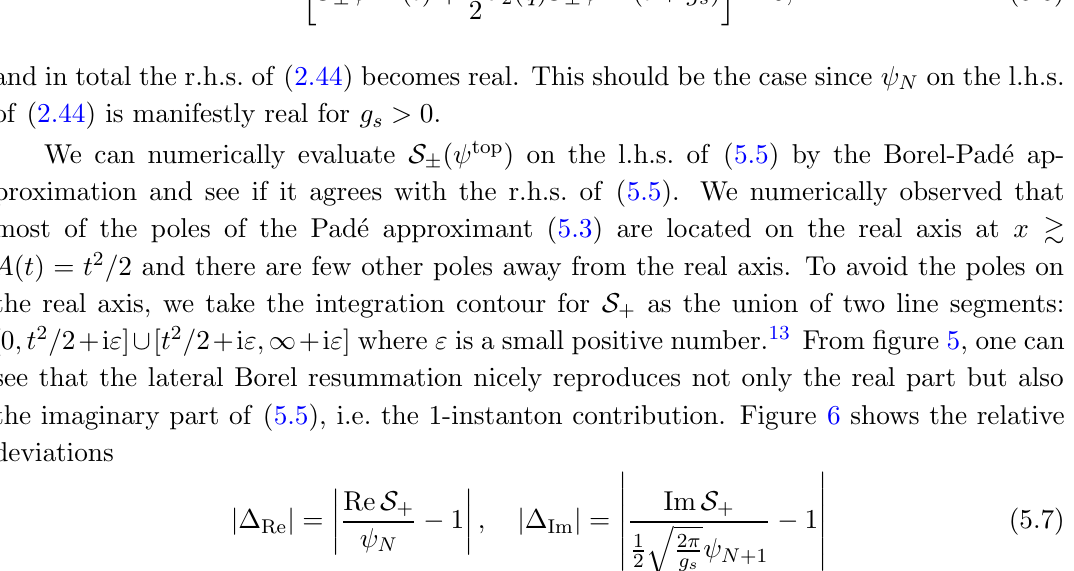
Figure 5 . Comparison of the nonperturbative result N + i Borel resummation S + ( top ) (blue solid line) at g s = 1. The real part (left) and the imaginary part (right) are plotted